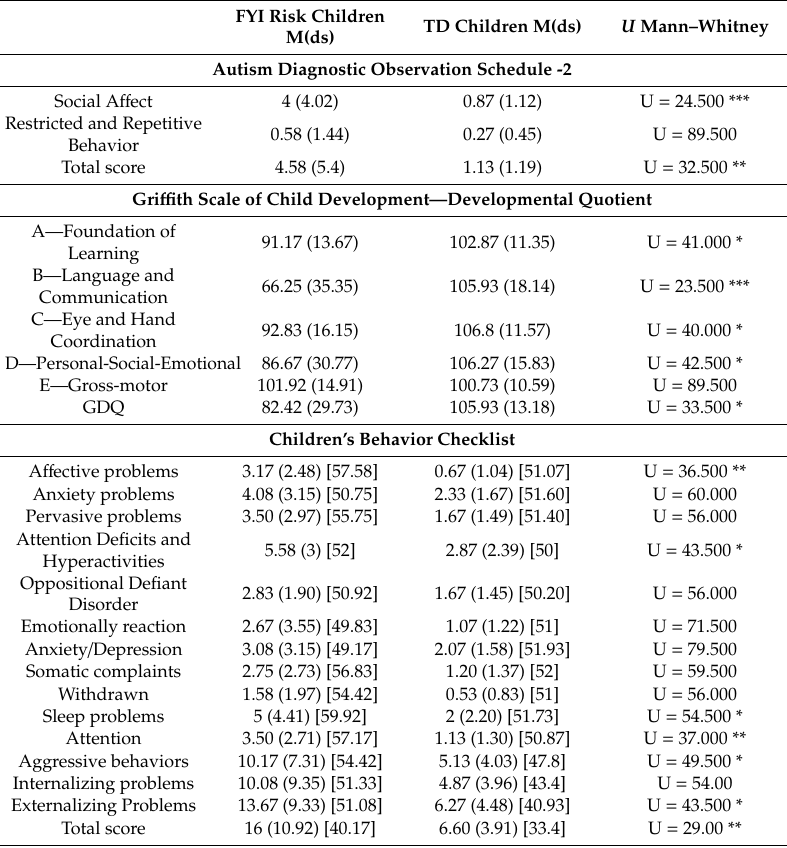
Table 3. Mean scores, standard deviation, and Mann–Whitney U